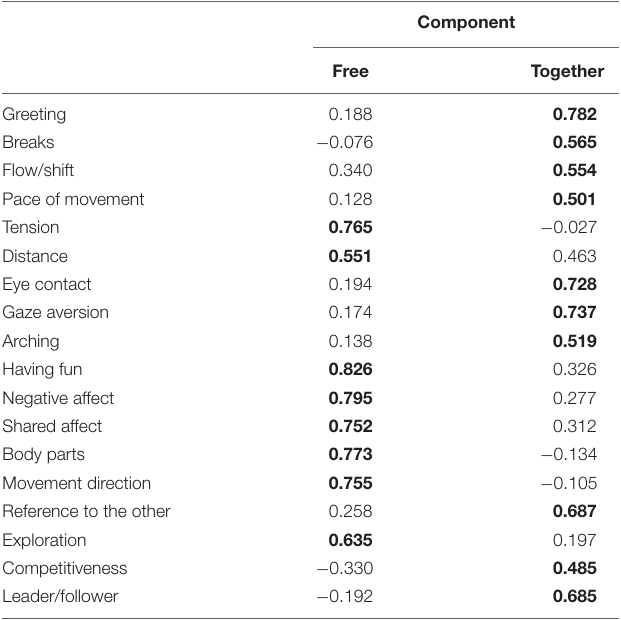
∗ Rotation Method: Varimax with Kaiser normalization. ∗ The higher loading of the two PCs marked in bold.